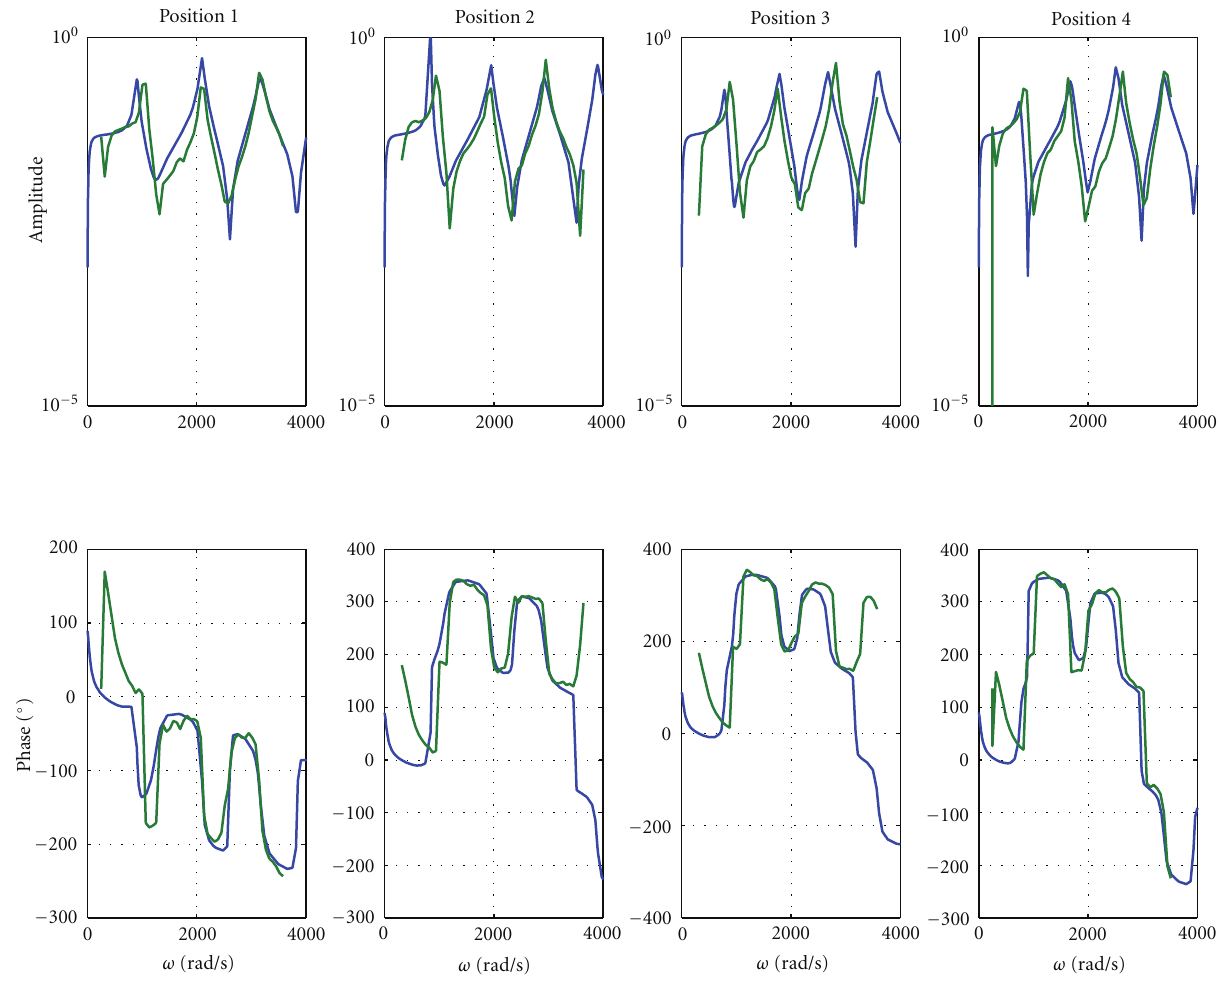
Figure 4: Comparison of frequency response of measurements (green) and analytical model